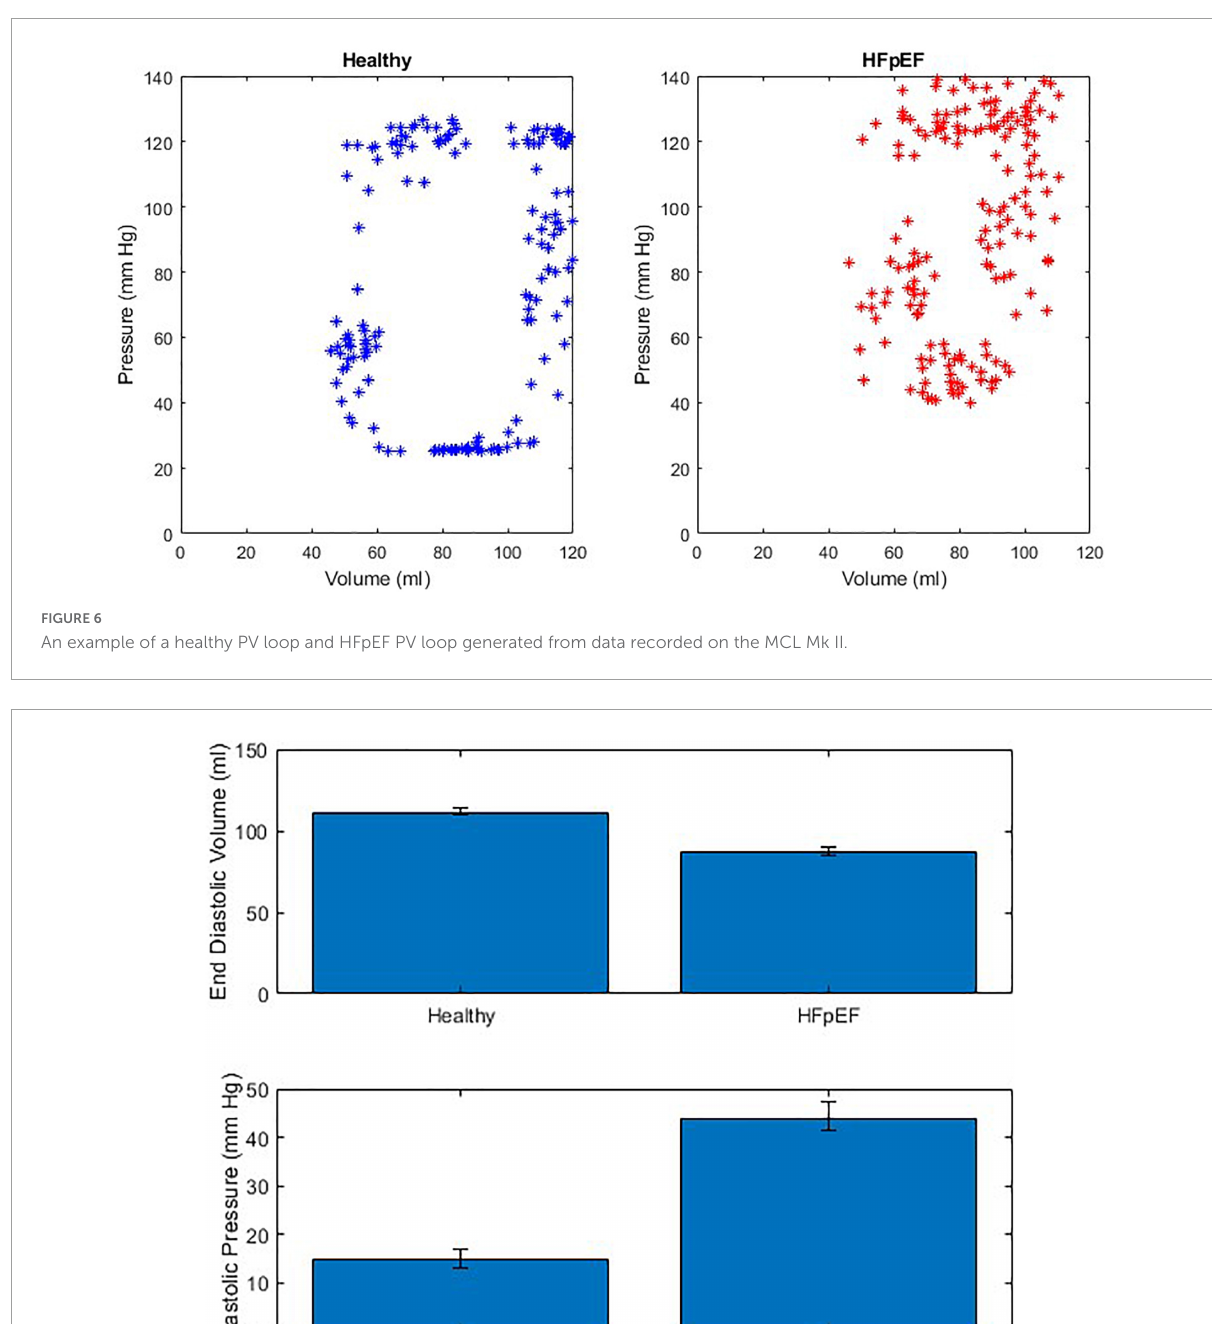
These values can be compared to values for end diastolic pressure and volume in the literature: The expected EDV decrease with HFpEF is from 121 (101–132) to 101 (86–105) as measured using echocardiography and the expected end diastolic pressure increase with HFpEF is from 8.0 (7.0–10.9)